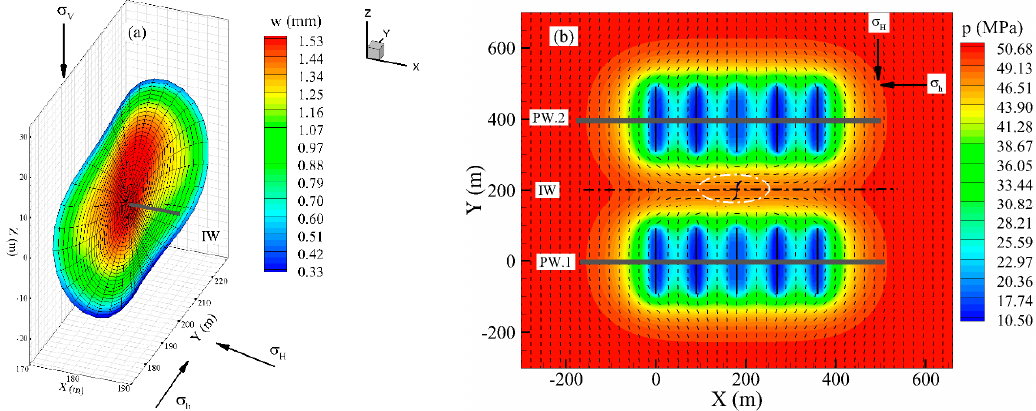
Figure 21. Infill well fracture propagation before repressurization of the production well fractures in the normal faulting stress regime after 3 years of production: ( a ) generated fracture geometry, ( b ) plan-view of the propagated fracture geometry on top of the reservoir pore pressure plot. Due to complete stress state reversal near the infill zone, a longitudinal fracture is created from the infill well.